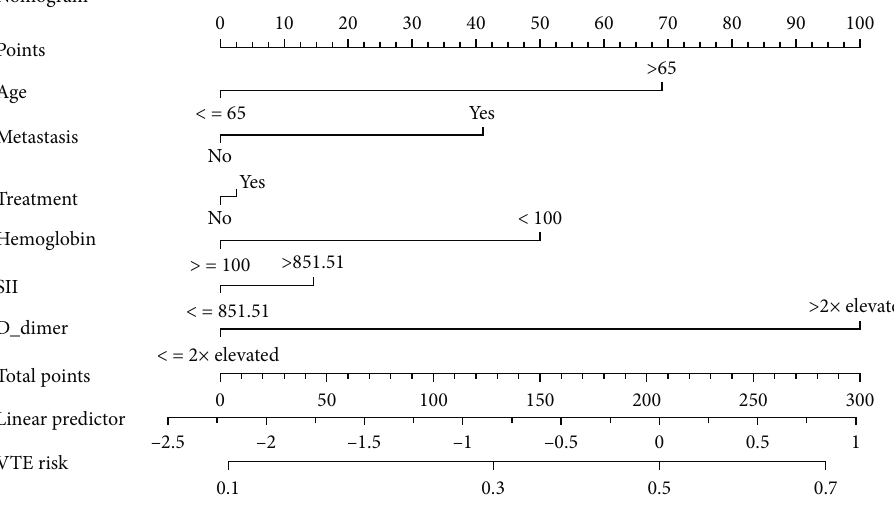
Figure 2: The nomogram for predicting VTE risk in lung cancer patients based on the systemic immune-in fl ammatory index (SII). Di ff erent scores were obtained for each variable, after which the total scores of the 6 items were assessed for the corresponding VTE predicted risk.